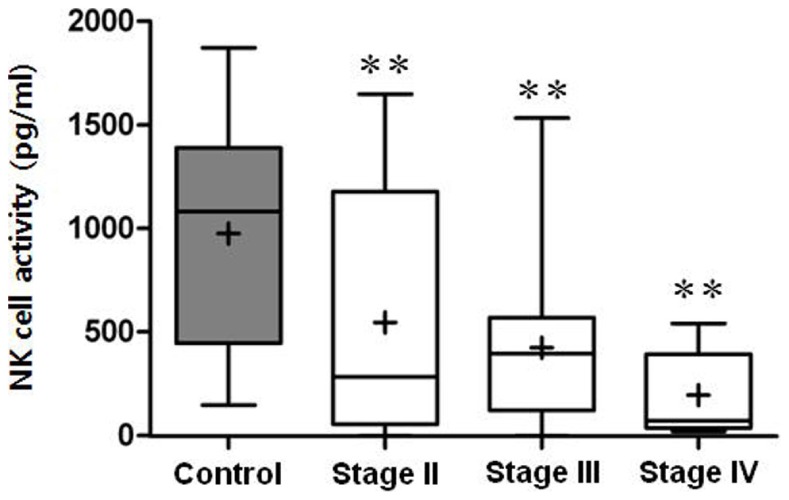
Boxplot diagram comparing NK cell activity between controls and patients grouped according to cancer stage.**p<0.01 in relation to controls.